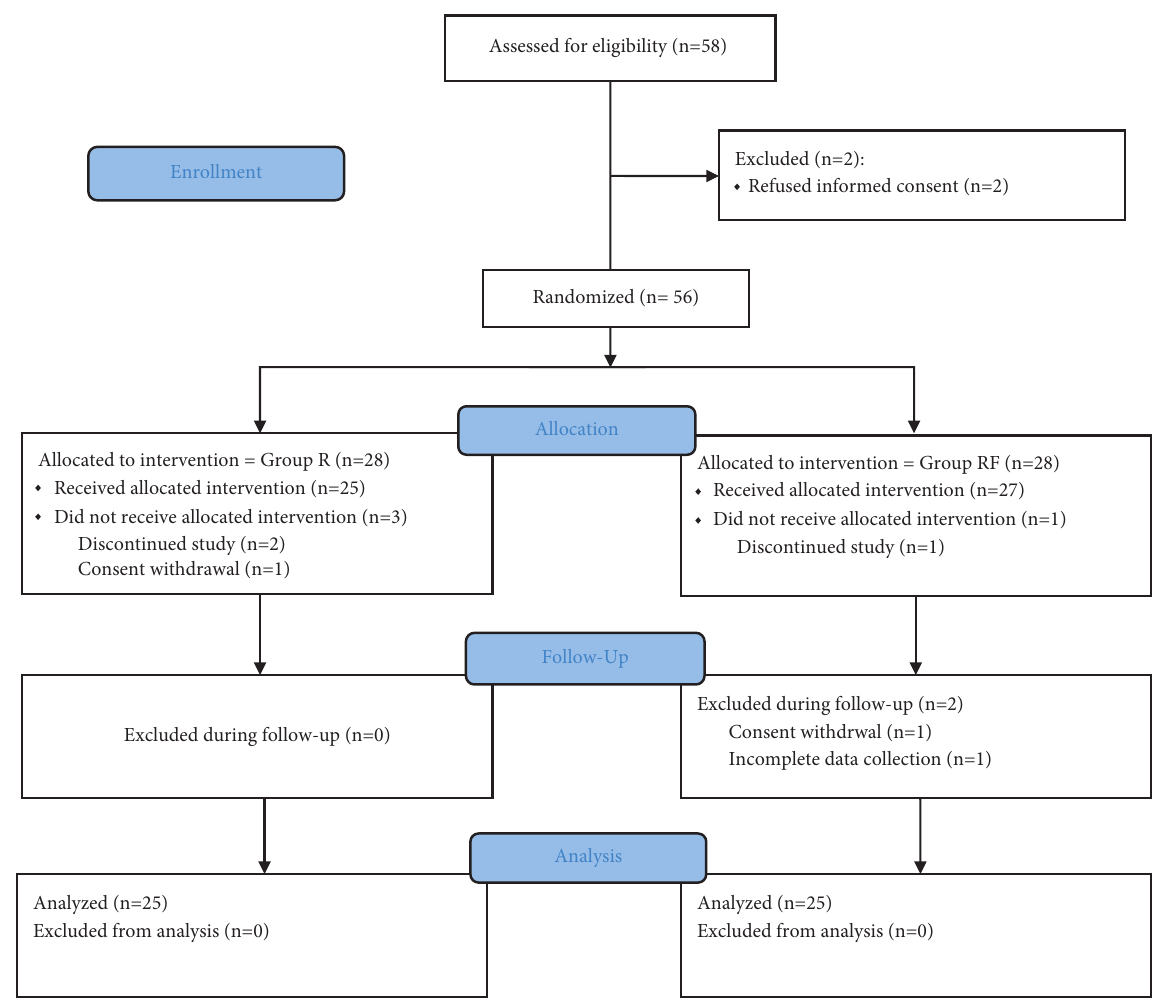
Figure 1: Flowchart of the study. Table 1: Patient characteristics and surgical